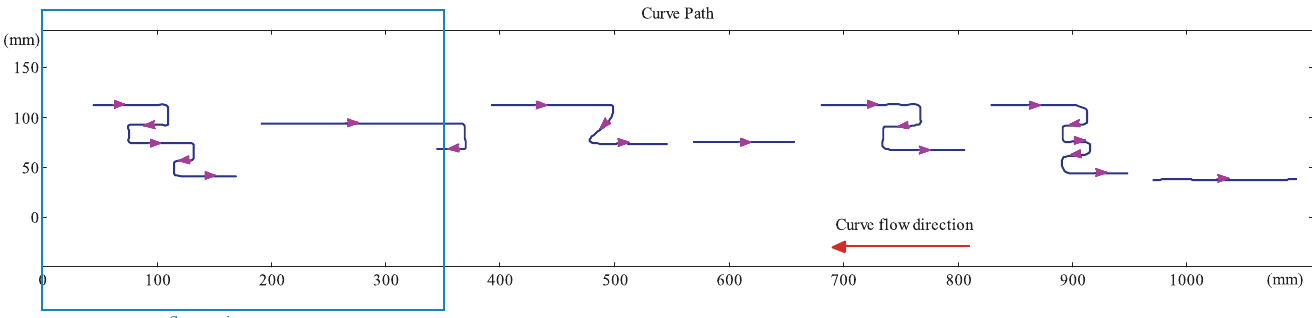
Fig 3. The curve path used in TE. For each condition the sequence of the curves are changed in order to prevent the subject from memorizing the order. The curve path repeats itself with the same sequence until the subject completes tracking within the given time. Curves are given in the same aspect ratio as they are seen on the touch monitor. This figure is 1:4 reduced in dimension to fit the margins. Curves flow from right to left. As in ME, each curve is designed such that tracking the curve with the index finger imitates reading of a short Braille sentence. The parts of the curve that point to left mimic reversals in Braille